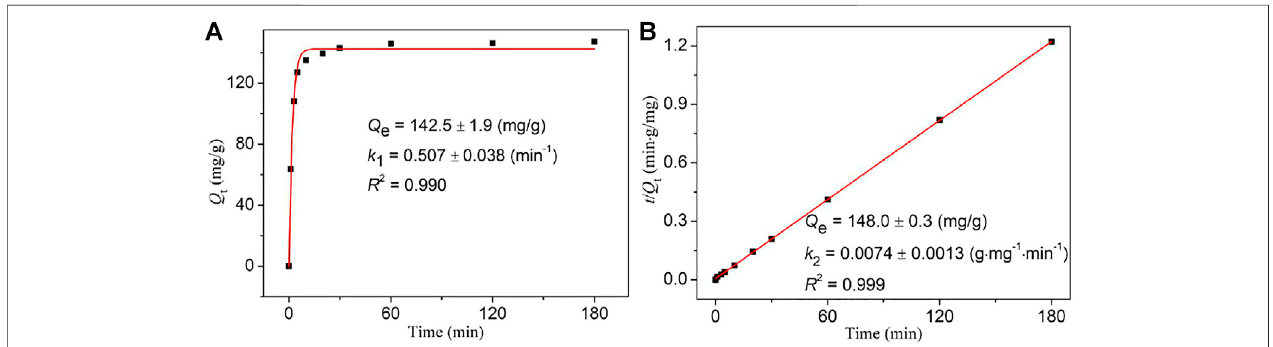
FIGURE 3 | Pseudo- fi rst (A) and pseudo-second order (B) kinetic models for the iodine adsorption kinetics of NS-1 with the initial concentration of 300 mg/L cyclohexane solution.